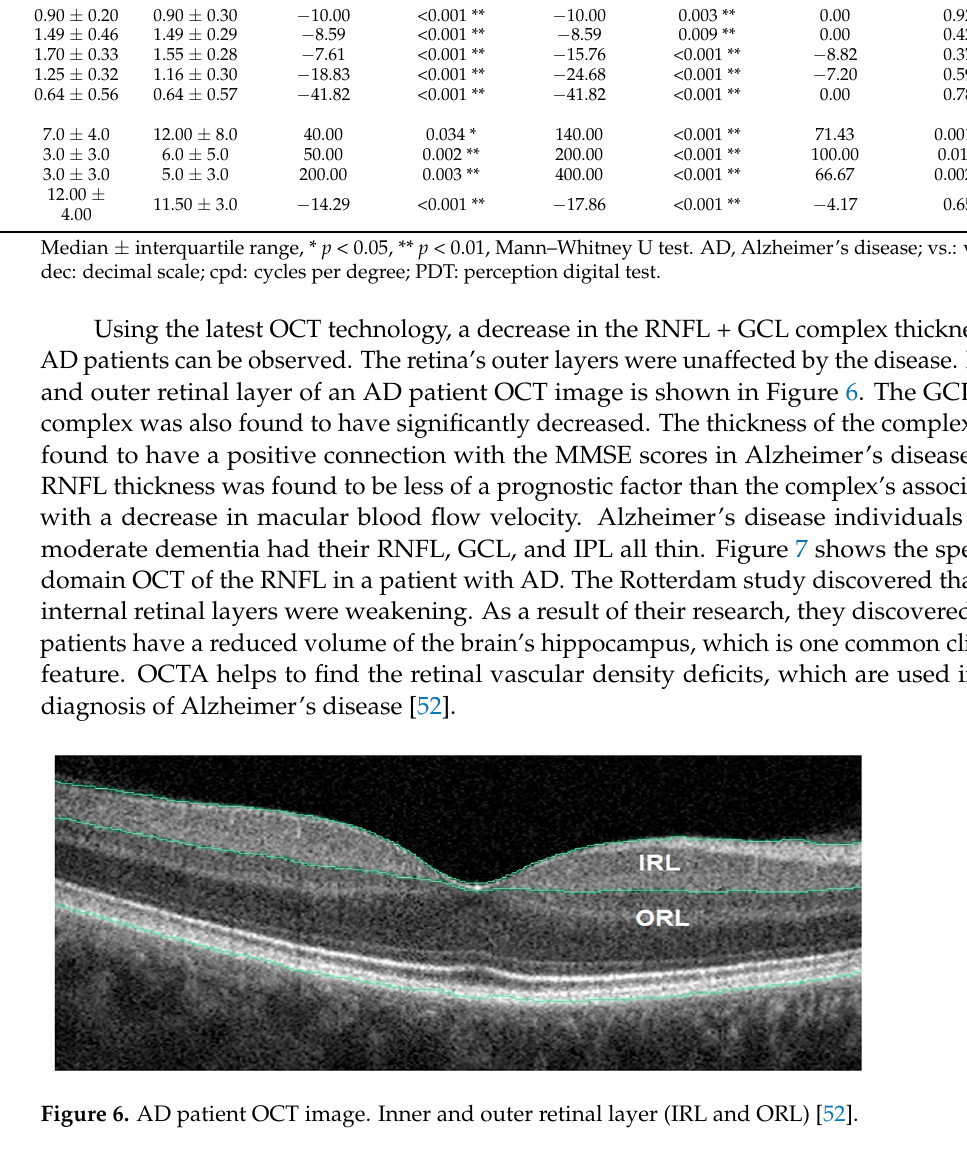
Figure 7. RNFL of an Alzheimer’s disease patient [23].